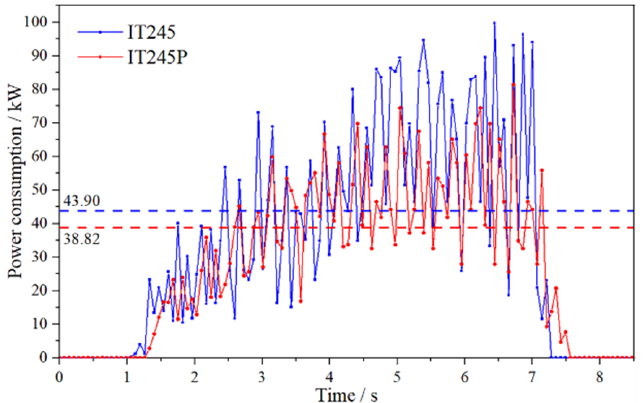
Figure 15. Power consumption curve of rotary blade.